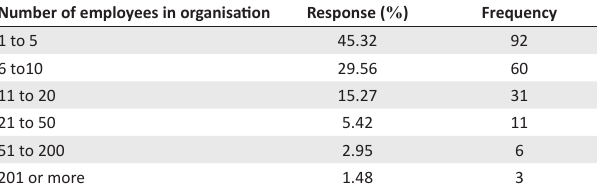
TABLE 4: Percentage response and frequency of number of employees ( N =